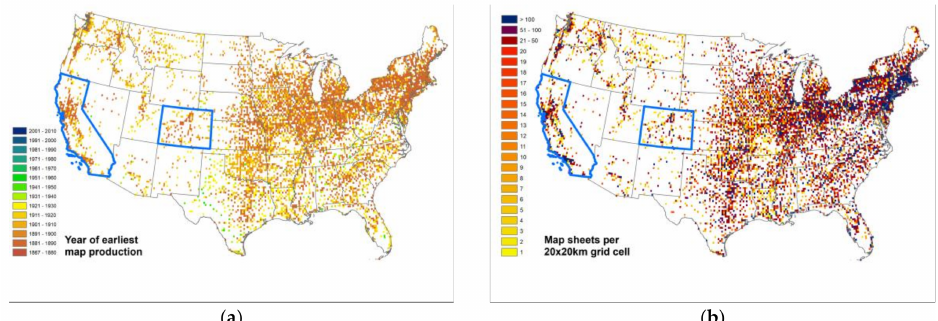
Figure 8. Sanborn fire insurance map archive coverage: ( a ) year of first map production per location and ( b ) number of available map sheets per location, both aggregated to grid cells of 20 km for efficient visualization. Highlighted in blue are the states of California and Colorado for comparison to the USGS map coverage shown in the previous figures.